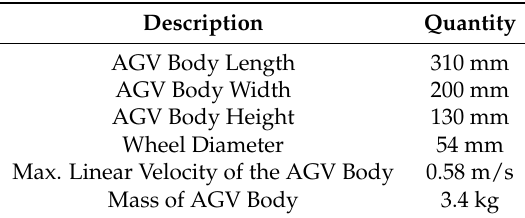
Table 1. Mecanum AGV dimensions and